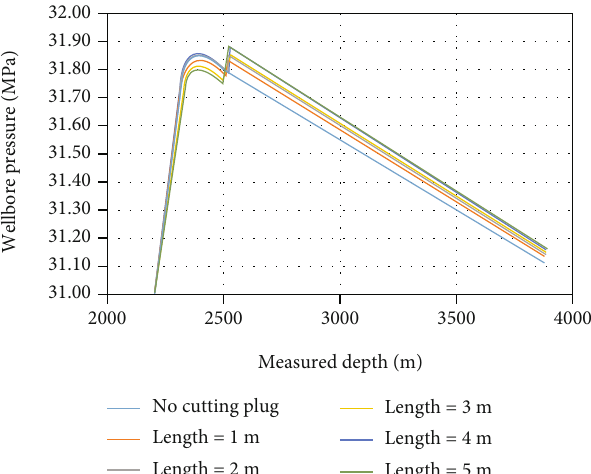
Figure 14: The e ff ect of cutting plug position on the swab pressures in an open pipe